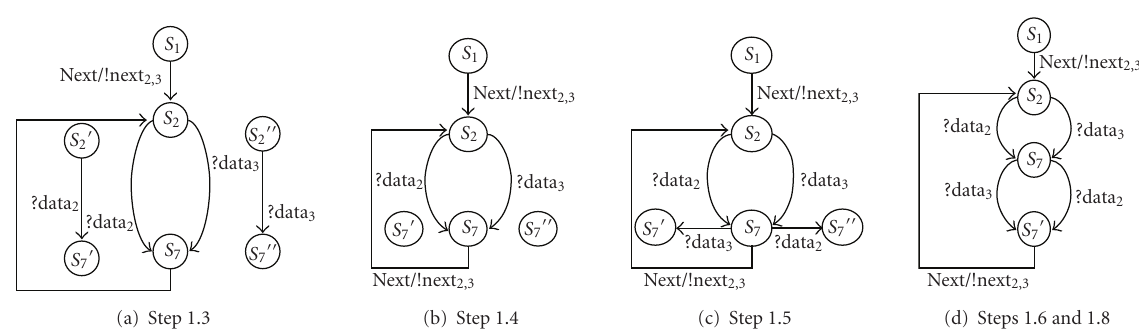
Figure 6: An application of the procedure given in Algorithm 5 for the PE-SPEC 1 given in Figure